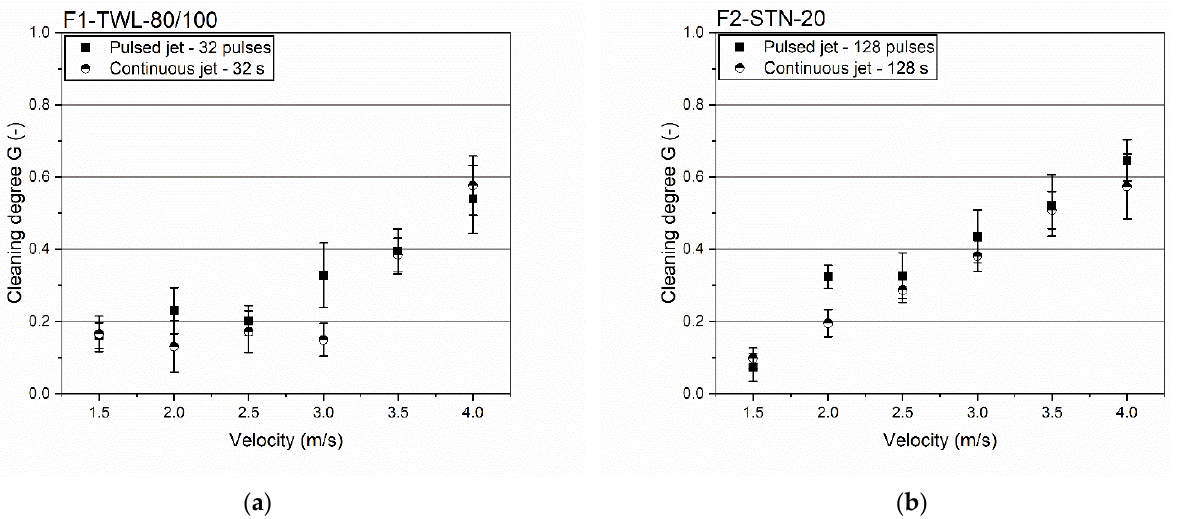
Figure 6. Velocity variation of v Nozzle regarding the transition area of pulsed and continuous